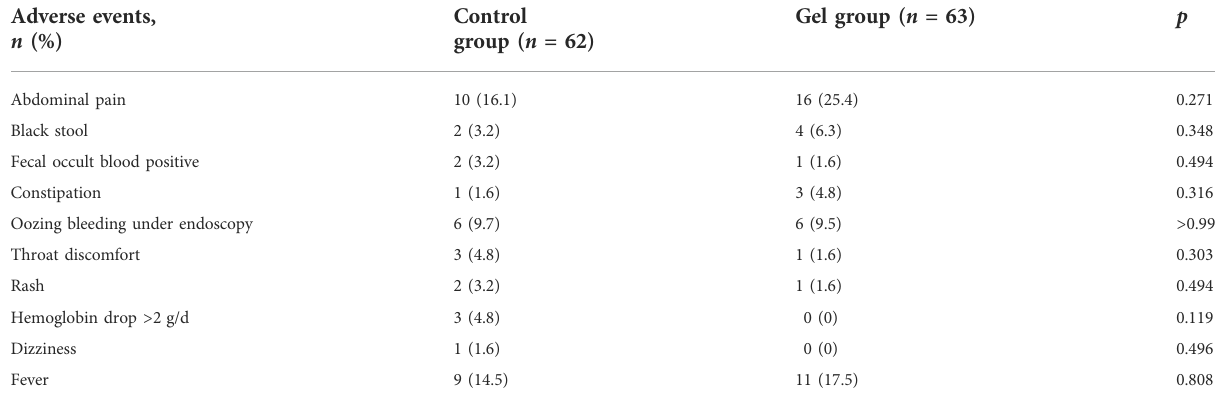
TABLE 3 Adverse